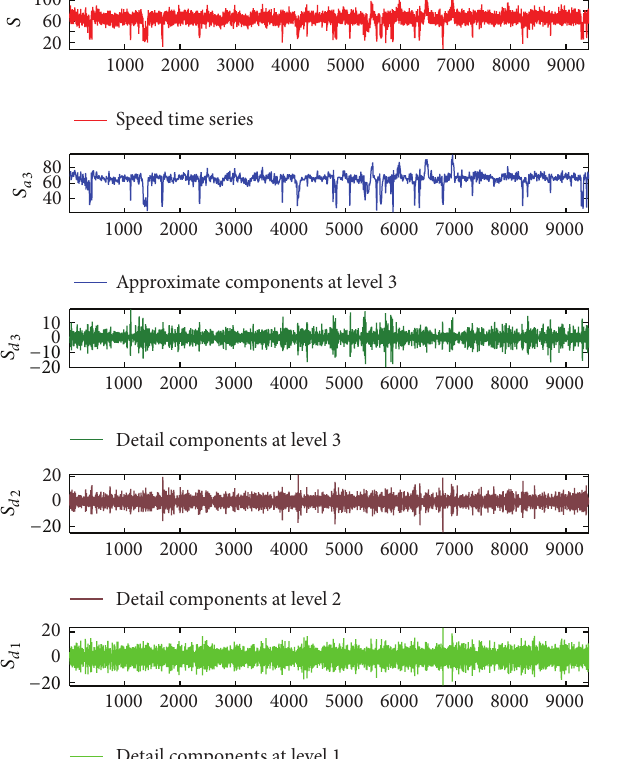
Figure 5: Occupancy time series wavelet decomposition at the 15th detector. Self-similarity is present at each decomposition level in wavelet decomposition diagrams on occupancy. Symbols qualitatively show the chaos existence in occupancy time series.